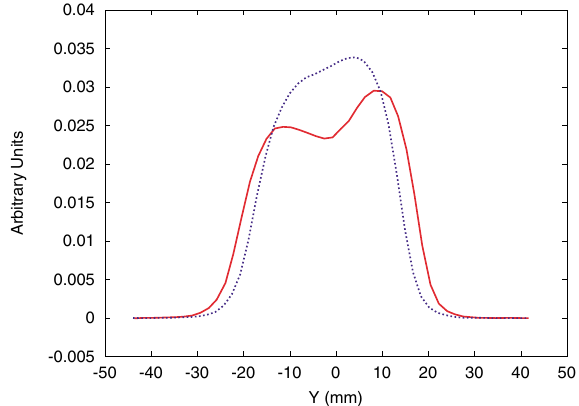
FIG. 21. (Color) Simulated vertical rms emittances versus turn for the full accumulation of the beam, followed by 1000 turns of beam storage. The solid (red) line shows the case for (cid:4) 2 : 19 , the dashed (green line shows the case for (cid:4) the dotted (blue) line shows the case for (cid:4) vertical line marks the end of accumulation at 3423